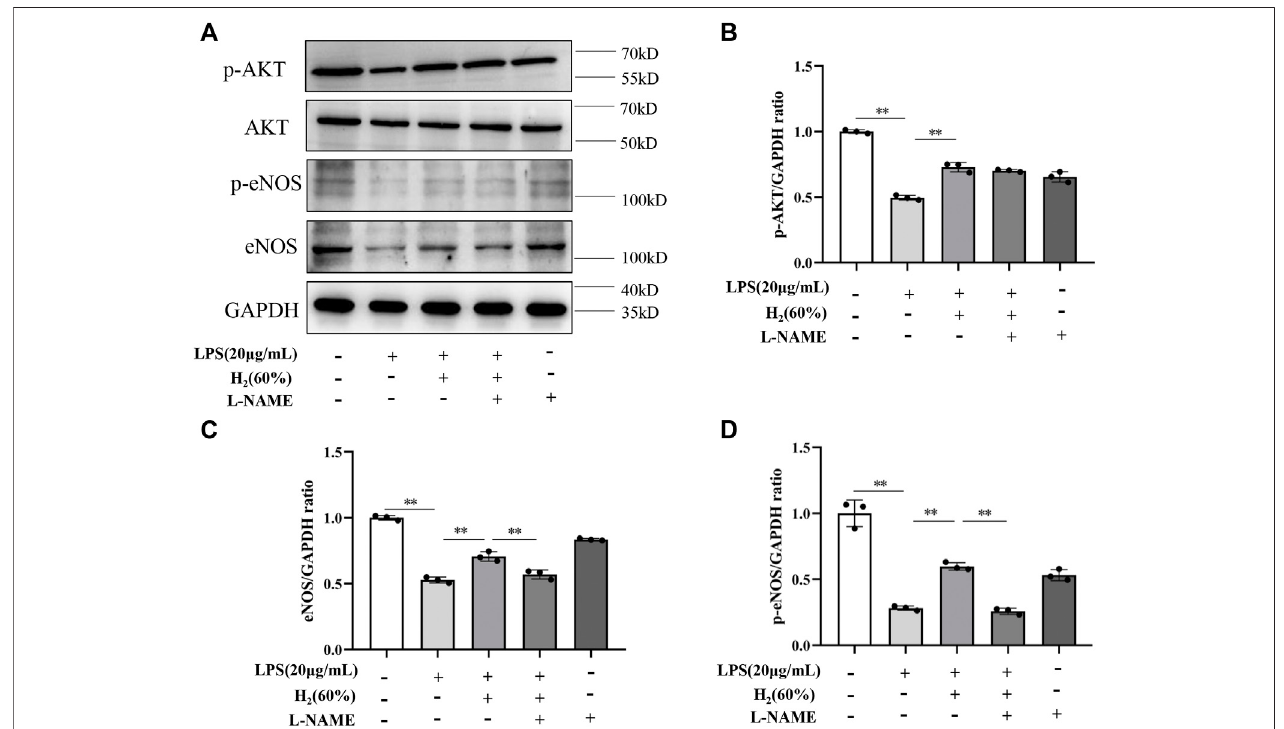
FIGURE 7 | (A) Representative western blot images. L-NAME inhibited the increase of eNOS (C) and p-eNOS (D) expression induced by H 2 (60%), and did not affectp-AKTlevels (B) .CellsweretreatedwithLPS(20 μ g/ml),H 2 (60%)andL-NAME(200 μ M)for2 h,respectively.Westernblottingwasusedtodetecttheexpression levels of target protein. Data are presented as mean ± SD; ** p < 0.01.